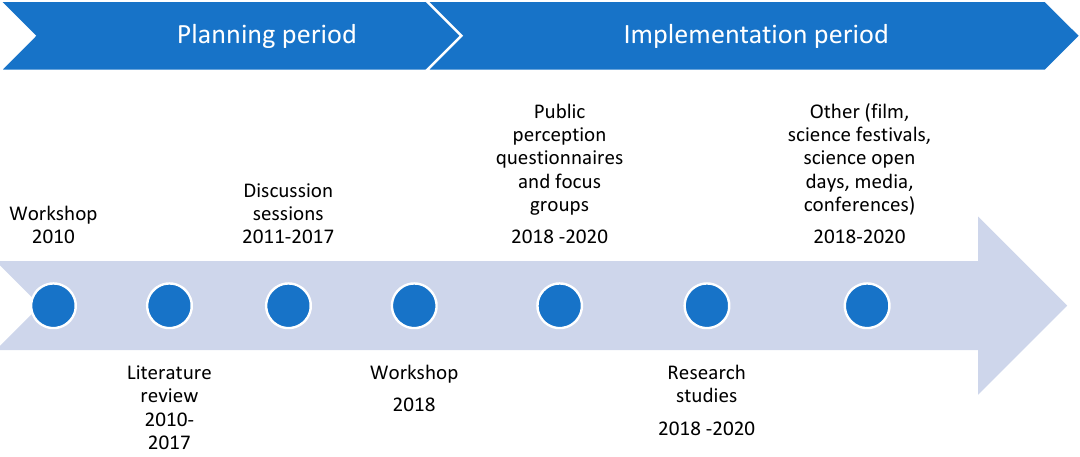
Figure 3. General workflow of the design and development of stakeholder involvement, engagement, and participation.